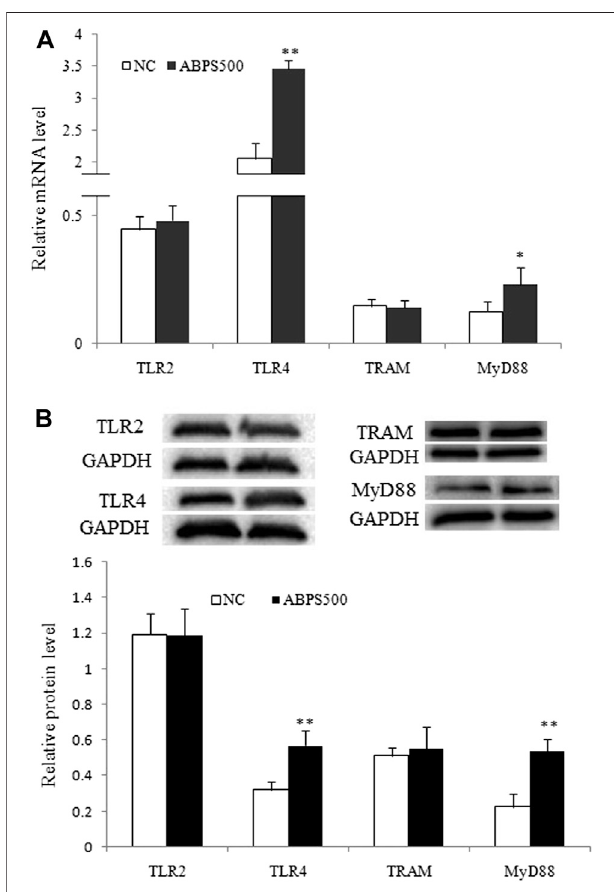
FIGURE 4 | ABPS increased the expression of TLR4 and MyD88 in J774 A.1cells. (A) ThemRNAexpressionofTLR2,TLR4,TRAM,andMyD88. (B) The protein expression of TLR2, TLR4, TRAM, and MyD88. The blot shown is representative of one of the three similar experiments. Cells were treated 500 μ g/ml ABPS for 24 h. NC: normal control; ABPS500: 500 μ g/ml ABPS treated. * p < 0.05, ** p < 0.01 vs. NC. The values are presented as means ±